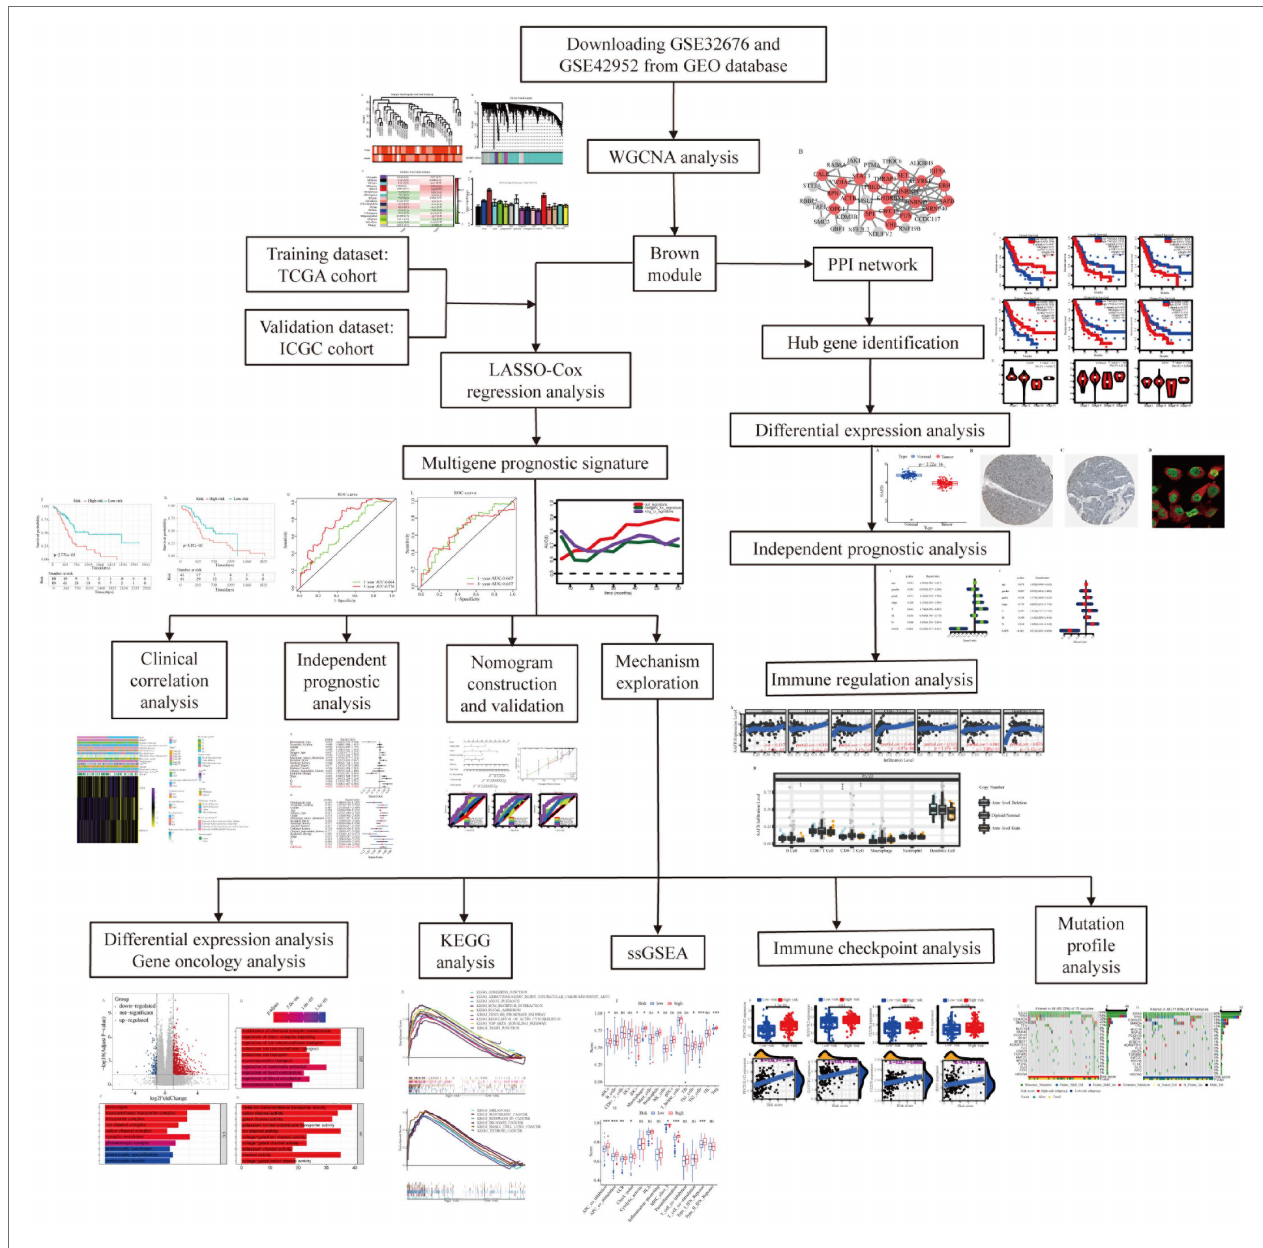
FIGURE 1 | Flow chart of the present